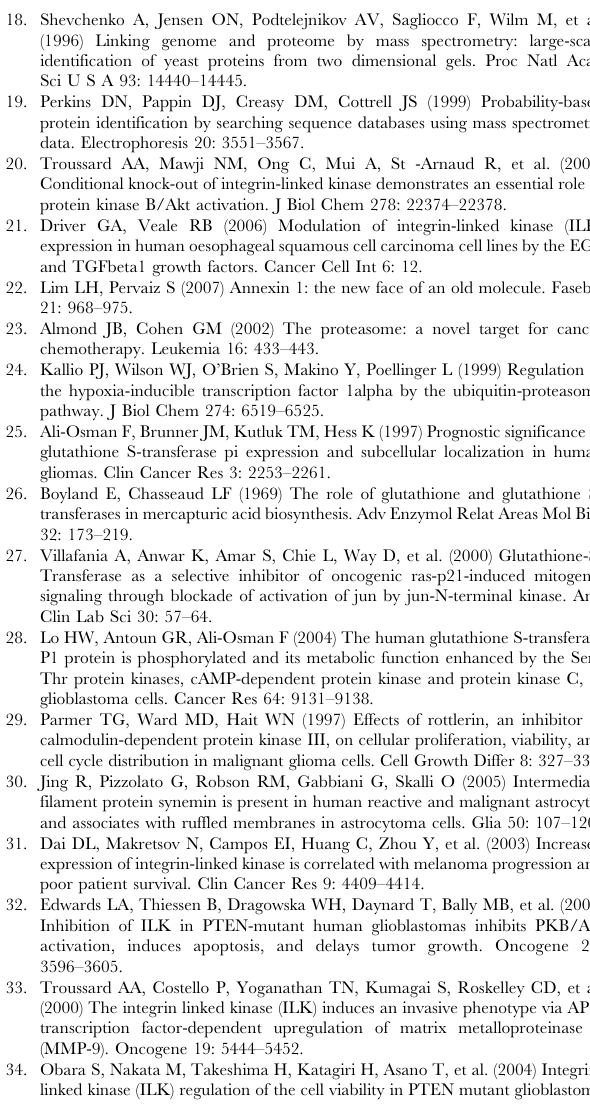
Figure S2 List of differentially expressed proteins identified by ing glioblastomas treated with PF4-DLR for 10 days with corresponding untreated tumors. The graph indicates the ratio PF4-DLR treated/untreated tumors (PF4-DLR/Crtl) normalized spot volume values of the identified proteins. Figure S3 List of differentially expressed proteins identified by MALDI-TOF after two- dimensional PAGE analysis by compar- ing glioblastomas treated with PF4-DLR for 20 days with corresponding untreated tumors. The graph indicates the ratio PF4-DLR treated/untreated tumors (PF4-DLR/Crtl) normalized spot volume values of the identified proteins.